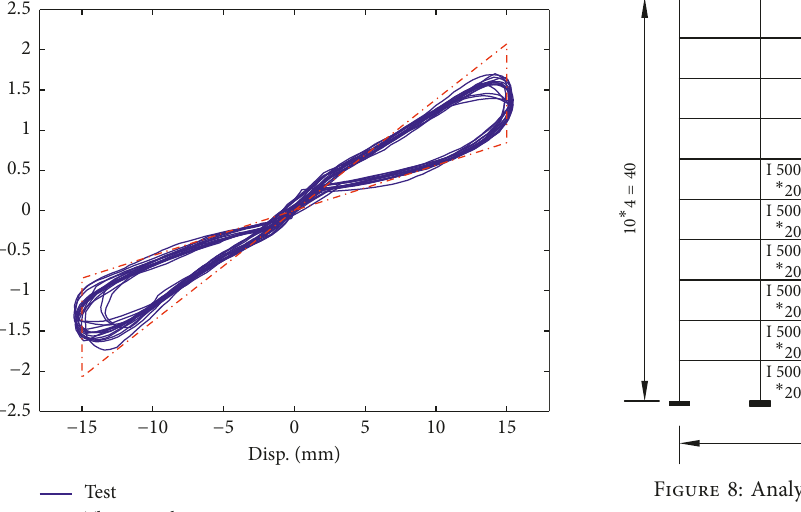
Figure 7: Force-displacement hysteretic curves of the damper.